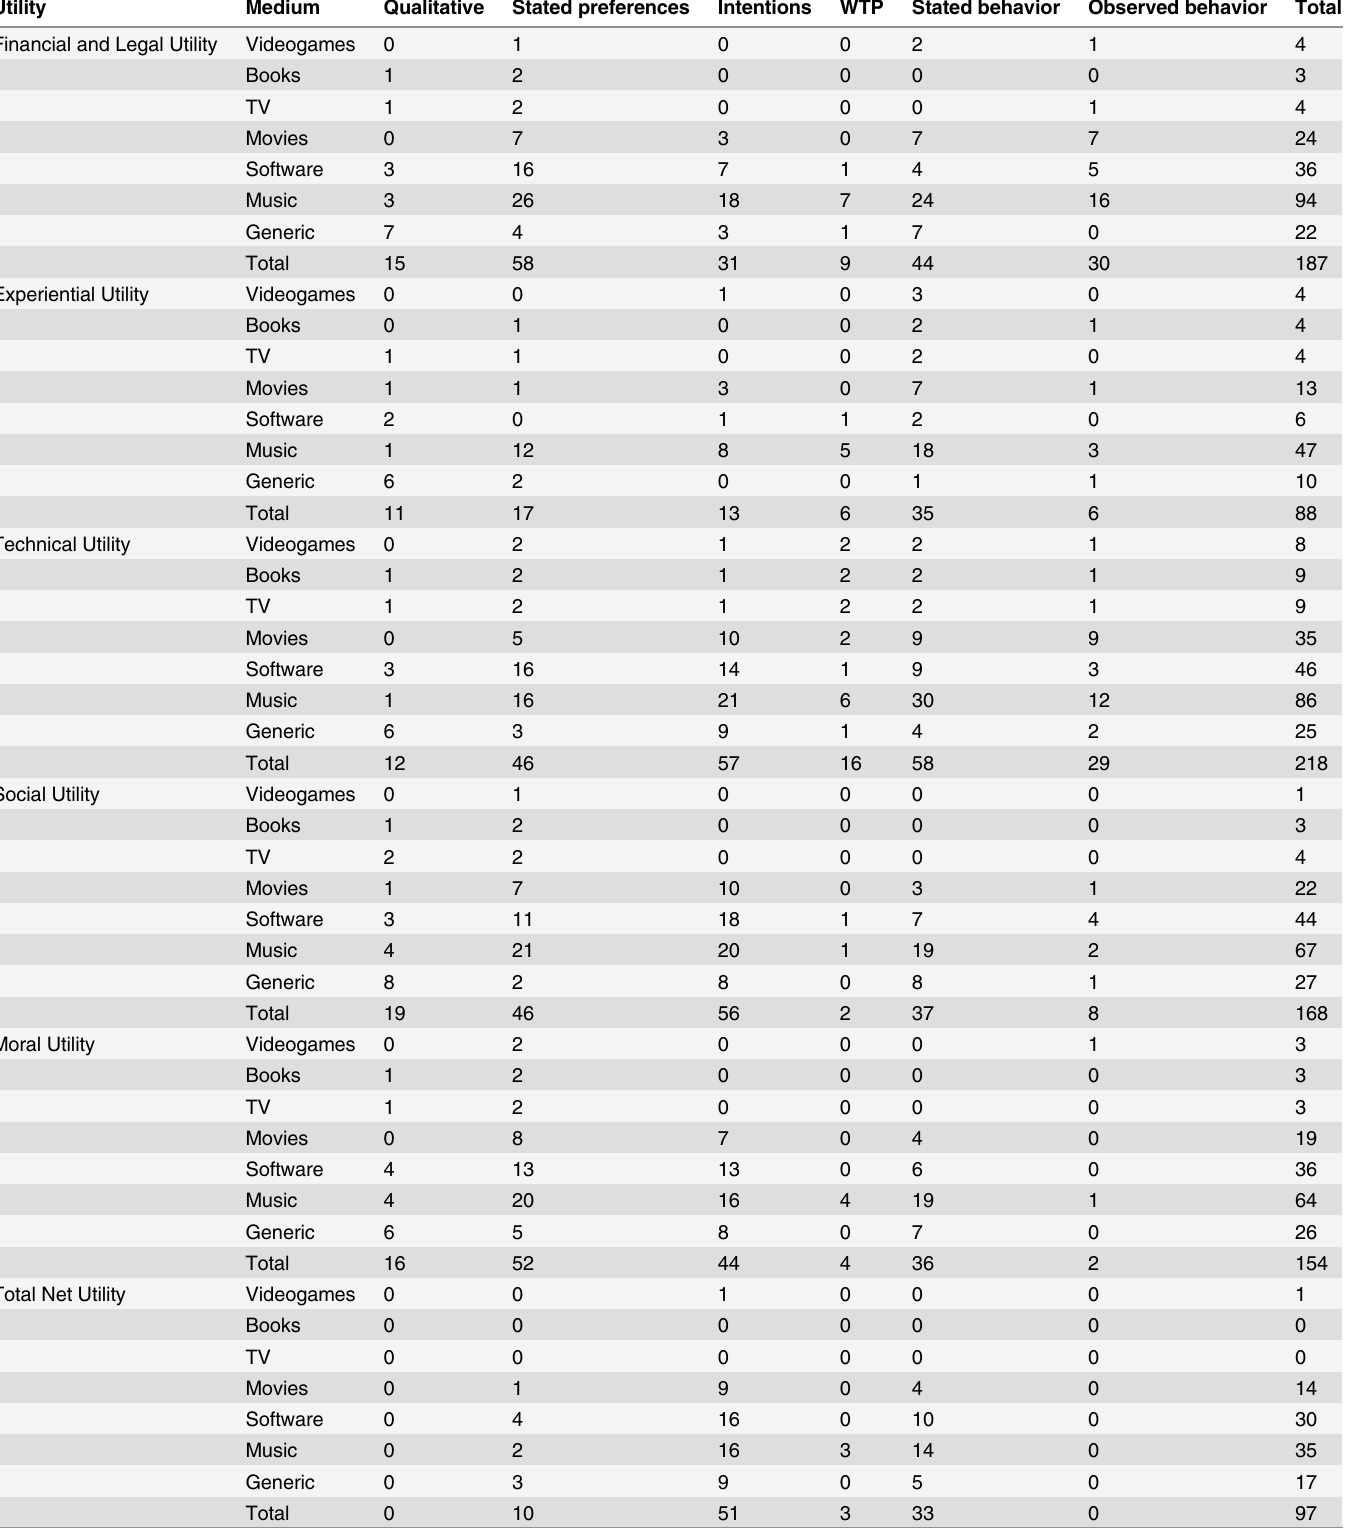
Table 5. Number of observations for each utility level, market medium and outcome measure.